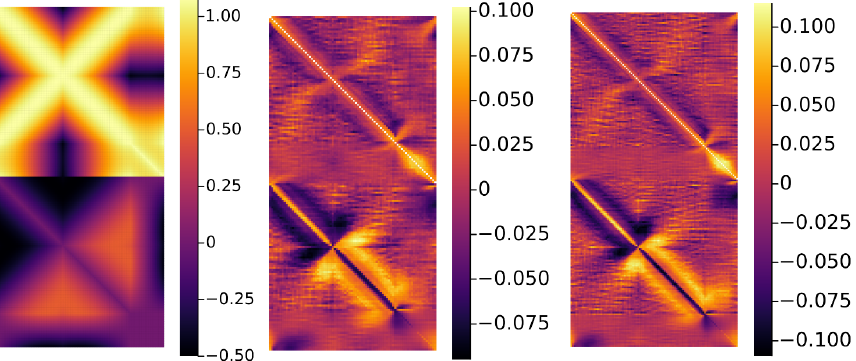
Figure 9 . (left) Free theory kernel for the SK contour with mt max = 1 . 5 . (center) The optimal learned kernel in the interacting theory for mt = 1 . 5 , which achieves correct convergence of CL. max The diagonal entries with values close to unity are subtracted from the kernel. (right) The kernel obtained as a result of the optimization procedure in the case of mt = 2 . 0 , which does not achieve max correct convergence. At the turning point at t and when connecting to the Euclidean domain max the kernel for the interacting theory shows nontrivial structure not present in the free